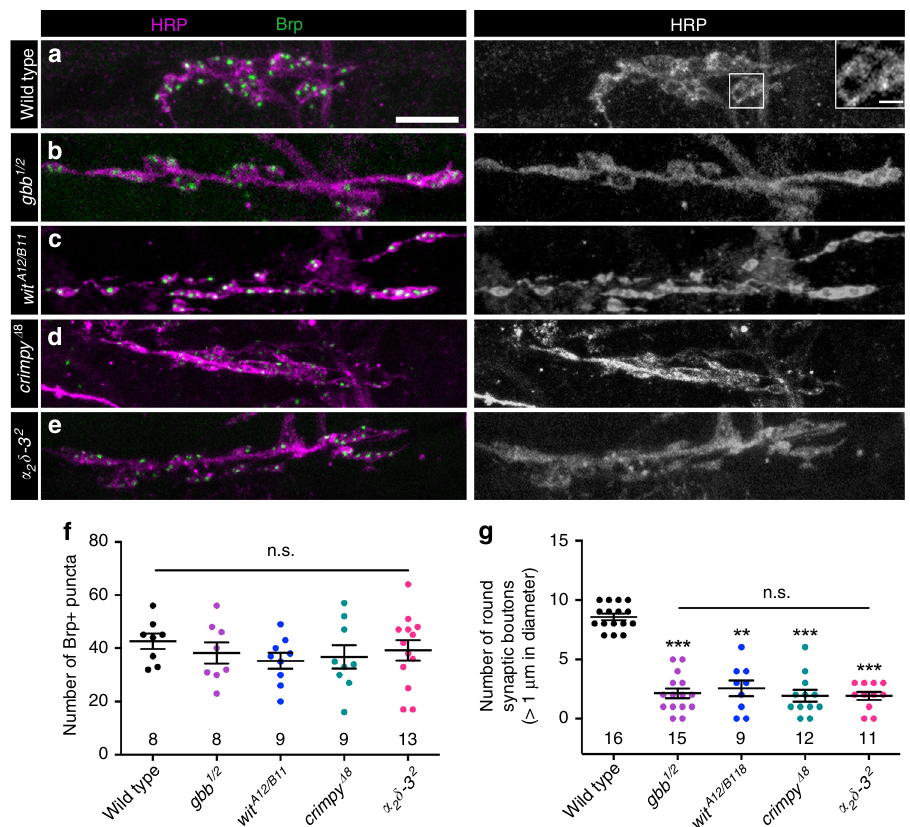
Fig. 6 Loss of Gbb phenocopies loss of α 2 δ -3 at embryonic NMJs. a – e Representative z -projections of embryonic NMJs of the indicated genotypes labeled with Brp (green) and HRP (magenta). Scale bar: 2 µ m. Inset in a depicts two synaptic boutons larger than 1 µ m in diameter. Scale bar: 1 µ m. f Quanti fi cation of the number of Brp + puncta. g Quanti fi cation of the number of synaptic boutons greater than 1 µ m in diameter. For all embryonic experiments, n is the number of NMJs scored. Error bars are mean ± SEM. Individual data points are displayed as dots. n.s. not signi fi cantly different. ** p < 0.01; *** p < 0.001. All tests are nonparametric Kruskal – Wallis one-way ANOVAs on ranks followed by Dunn ’ s multiple comparison